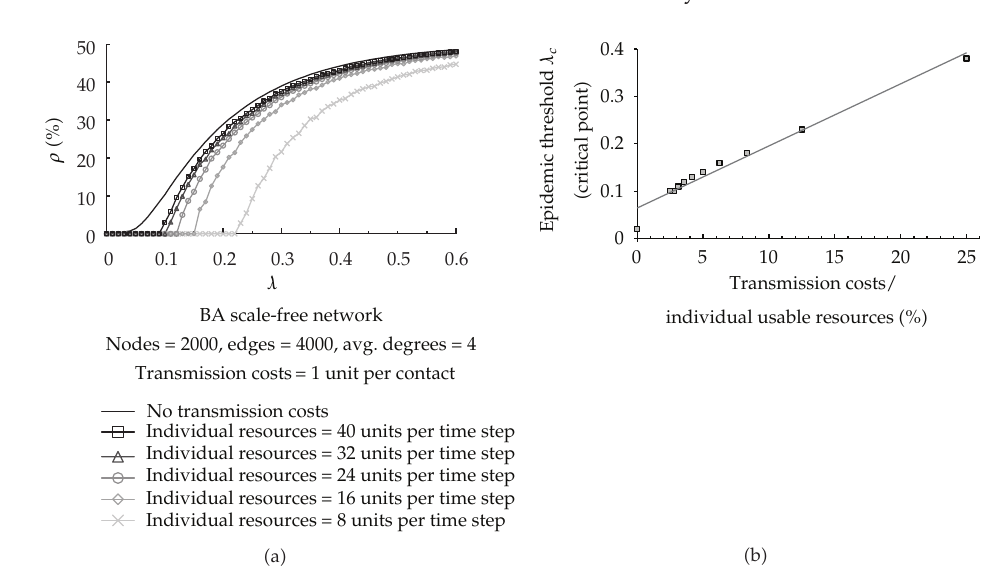
Figure 4: Simulation results for scale-free network #3. (cid:3) a (cid:4) The amount of agent’s resources a ff ects density curves and epidemic tipping points. (cid:3) b (cid:4) Linear relationship between the ratio of interaction costs to agent’s resources and epidemic tipping